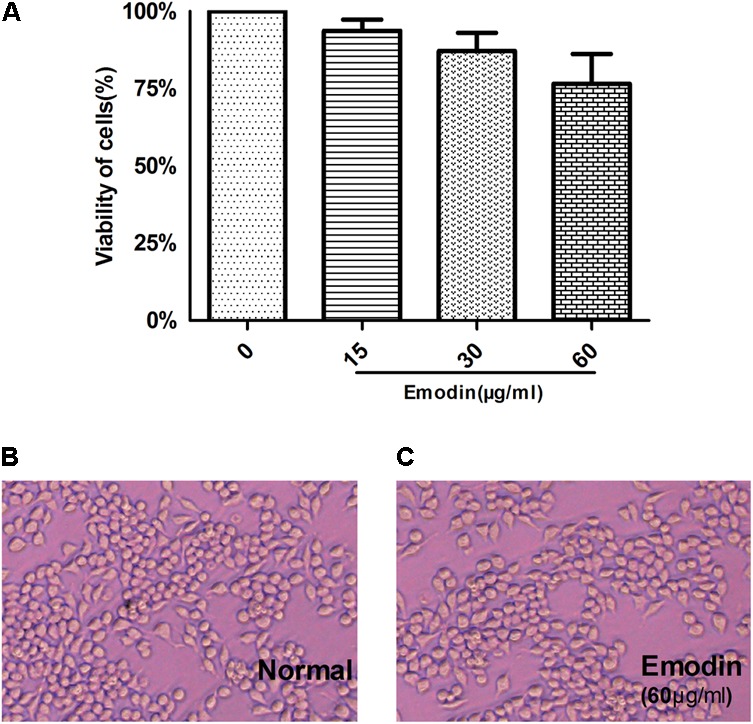
In vitro cytotoxicity of emodin. The cytotoxicity of emodin was evaluated by the CCK8 assay. (A) A CCK-8 assay of RAW264.7 cell viability after emodin treatment. (B) Morphologies of Raw264.7 cells. (C) Morphologies of Raw264.7 cells after emodin treatment for 24 h. Data are shown as the mean ± SD. N = 3.